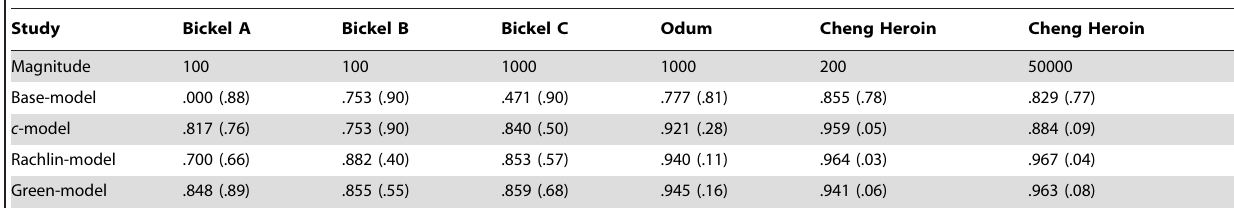
Table 2. Median R 2 for SA Group in Each